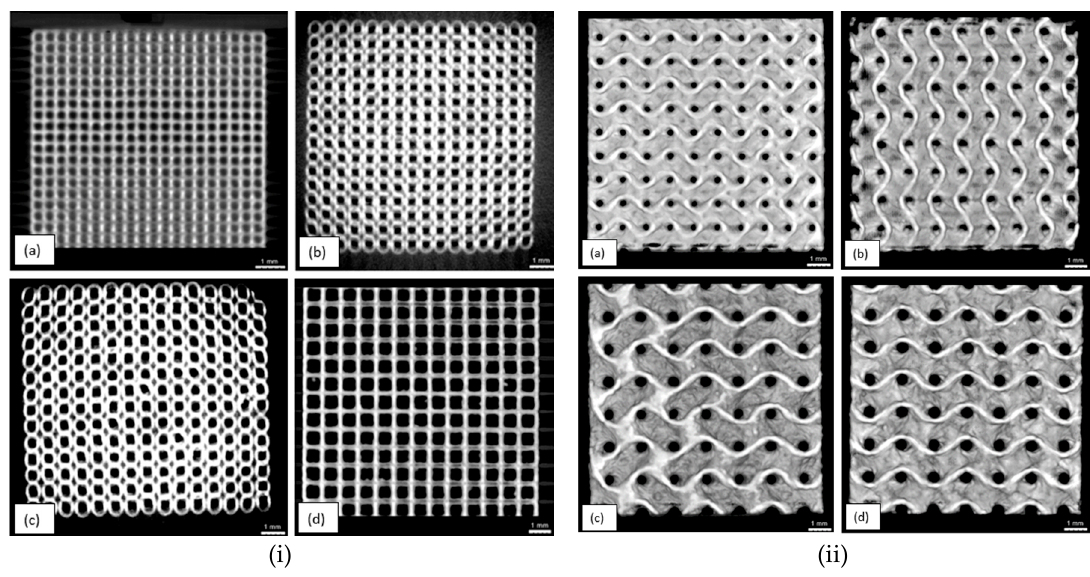
Figure 7. CT Image of ( i ) cube and ( ii ) gyroid sample: ( a ) 0.3 mm; ( b ) 0.4 mm; ( c ) 0.5 mm; and ( d ) 0.6 mm.